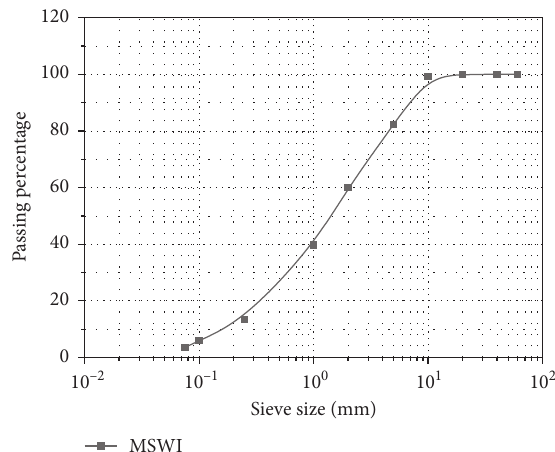
Figure 2: Gradation curve of the MSWI bottom